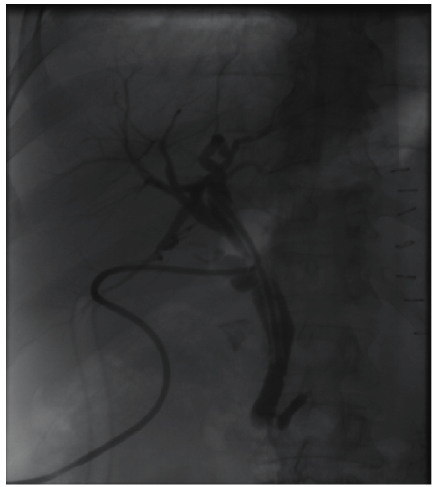
Figure 5: Cholangiography—no aberrant intrahepatic bile ducts are detected.